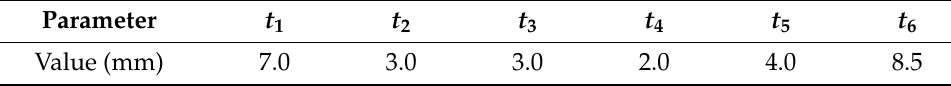
Figure 5. The response surfaces of the maximum output displacement versus structural parameters. ( a ) The response surface of t 1 and t 2 , ( b ) the response surface of t 3 and t 4 , and ( c ) the response surface of t 5 and t 6 . Table 1. The designed structure